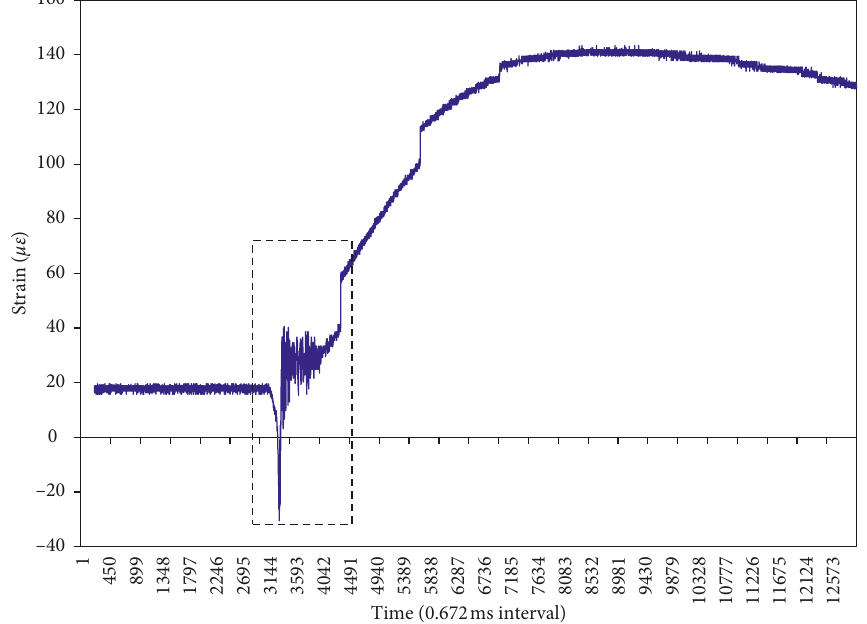
Figure 25: Fourth test full-term data.